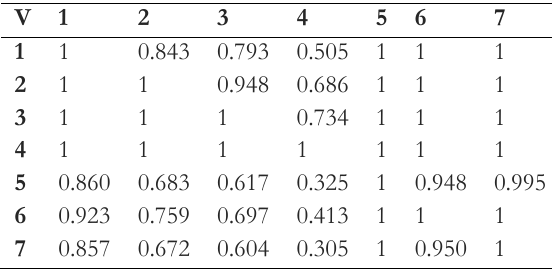
Table 4. The calculated V